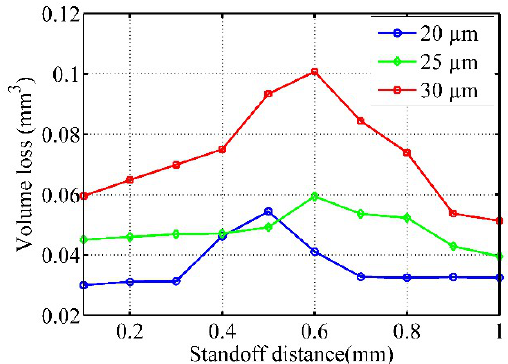
Figure 4. Volume loss at different standoff distance and different vibration amplitudes.